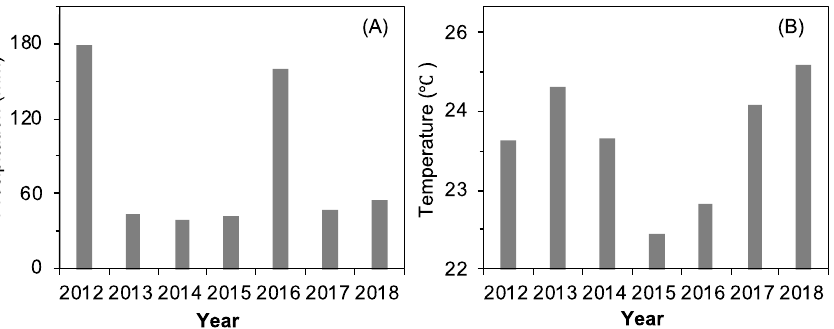
Figure 1. Variations in the accumulated precipitation ( A ) and average air temperature ( B ) from 1 June to 31 August of 2012–2018.